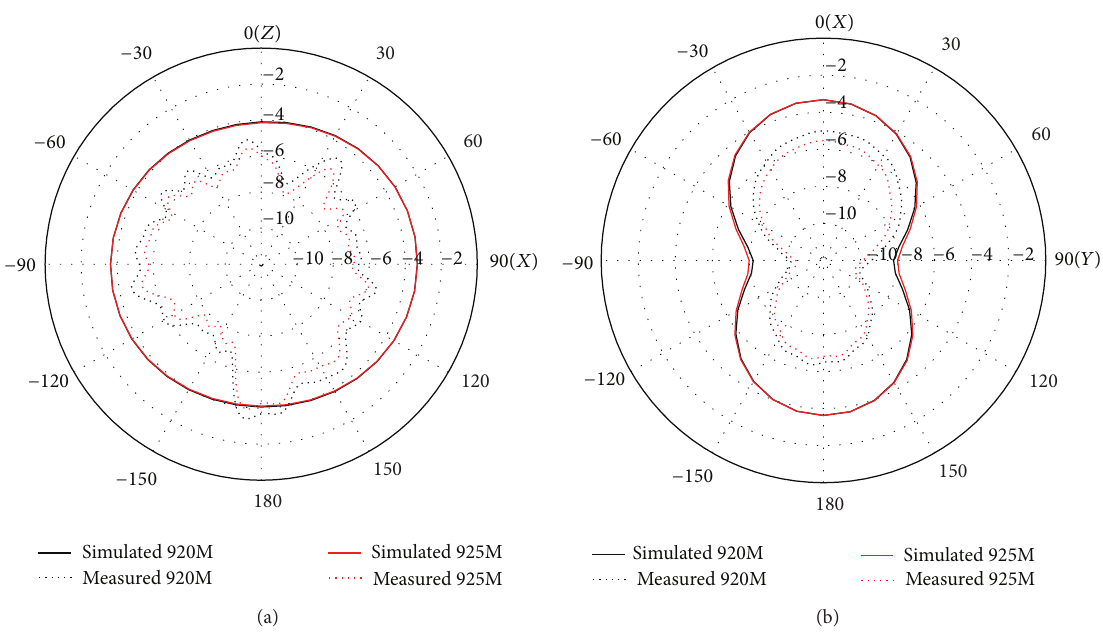
Figure 9: Simulated and measured far-field radiation patterns at (a) 𝑥𝑧 -plane and (b) 𝑥𝑦